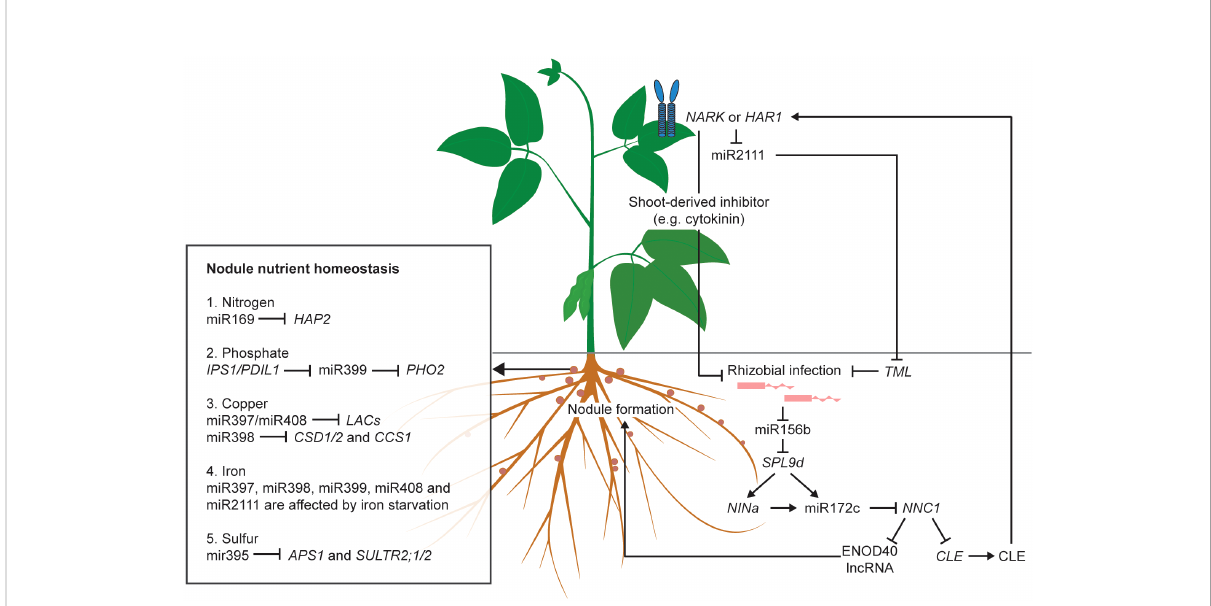
FIGURE 1 Roles of validated non-coding RNAs (ncRNAs) in AON pathway and nodule nutrient homeostasis of legumes. Without rhizobial infection, miR2111 is transported from shoot to root to inhibit the symbiosis suppressor TML , thus maintaining the legume host at an infection-susceptible default status. Rhizobial infection reduces the expression of miR156b to release its inhibition on the downstream symbiosis activators, such as miR172c and NINa . The activation of the long non-coding RNA (lncRNA) of ENOD40 directly induces nodule formation. The induction of CLE produces the CLE peptides which is transported from root to shoot and perceived by the NARK/HAR1 receptor to suppress nodule formation, either by activating the shoot-derived inhibitors, such as cytokinin, or by repressing miR2111, thereby allowing TML to inhibit rhizobial infection. In the nodule, miRNAs and lncRNAs regulate nutrient homeostasis, such as those of nitrogen, phosphate, copper, iron and sulfur. Arrows indicate activation. Blunt ended arrows indicate